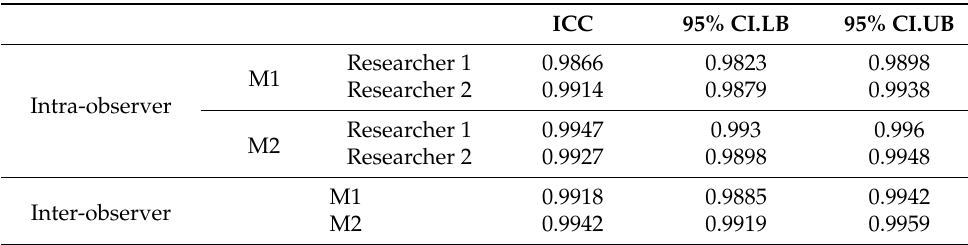
Table 1. Inter- and intraobserver reliabilities for all measurements calculated by the intraclass correlation coefficient (ICC). ICC 95% CI.LB 95% CI.UB M1 Intra-observer